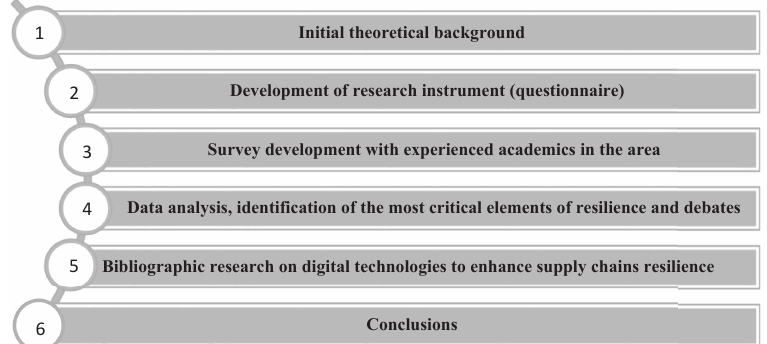
Figure 1. Stages took to